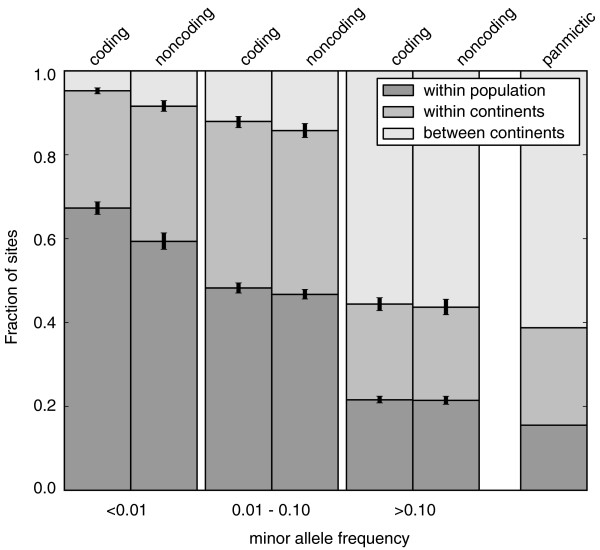
Allele sharing among populations in the Exon Pilot versus ENCODE intergenic SNPs. The probability that two minor alleles, sampled at random without replacement among all minor alleles, come from the same population, different populations on the same continent, or different continents, displayed according to minor allele frequency bin (<0.01, 0.01 to 0.1, and 0.1 to 0.5). For comparison, we also show the expected level of sharing in a panmictic population, which is independent of AF. The ENCODE and the Exon Pilot data have different sample sizes for each population panel, which could impact sharing probabilities. We therefore calculated the expected sharing based on subsets of equal size, corresponding to 90% of the smallest sample size for each population (section 9, 'Allele sharing among populations', in Additional file 1). To reduce possible biases due to reduced sensitivity in rare variants, only high-coverage sites were used, and individuals with overall low coverage or poor agreement with ENCODE genotypes were discarded. Error bars indicate the 95% confidence interval based on bootstrapping at individual variant sites.